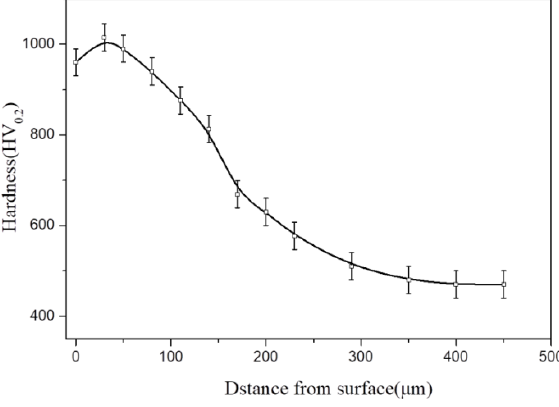
Figure 3. Cross-sectional hardness–depth profile for the nitrided specimen.